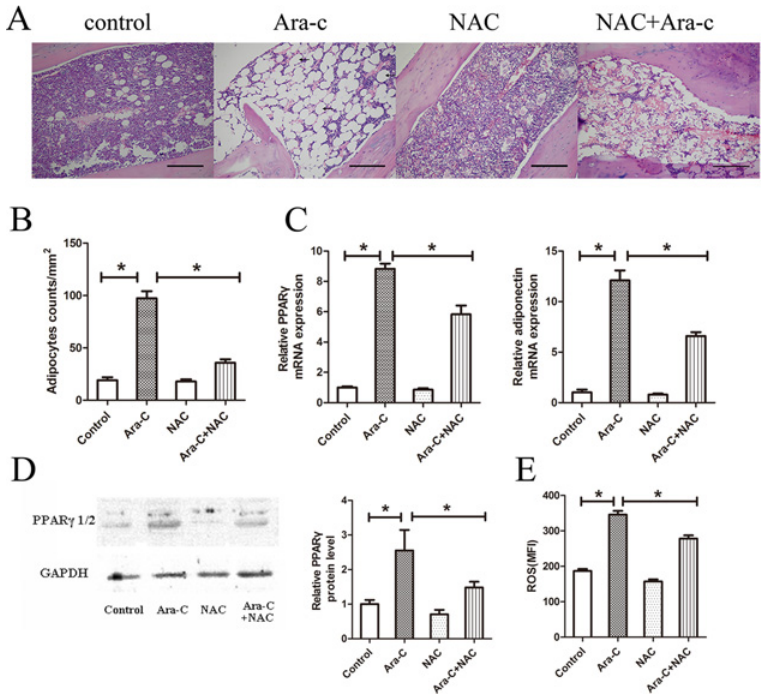
Fig 2. NAC diminishes adipogenesis induced by Ara-C in vivo . (A) BM section of the tibia from four groups on Day 7. Scale bar = 200 μ m. (B) Adipocyte counts per mm 2 in tibia BM sections. (C) Gene expression of PPAR γ and adiponectin in the long bone BM on Day 7. (D) Western blot analysis of PPAR γ protein on Day 7 of treatment in the long bone BM. (E) Mean fluorescence intensity of ROS in mouse BM- derived MSCs. ROS was quantified by FACS using the CM-H 2 DCFDA probe. * P <